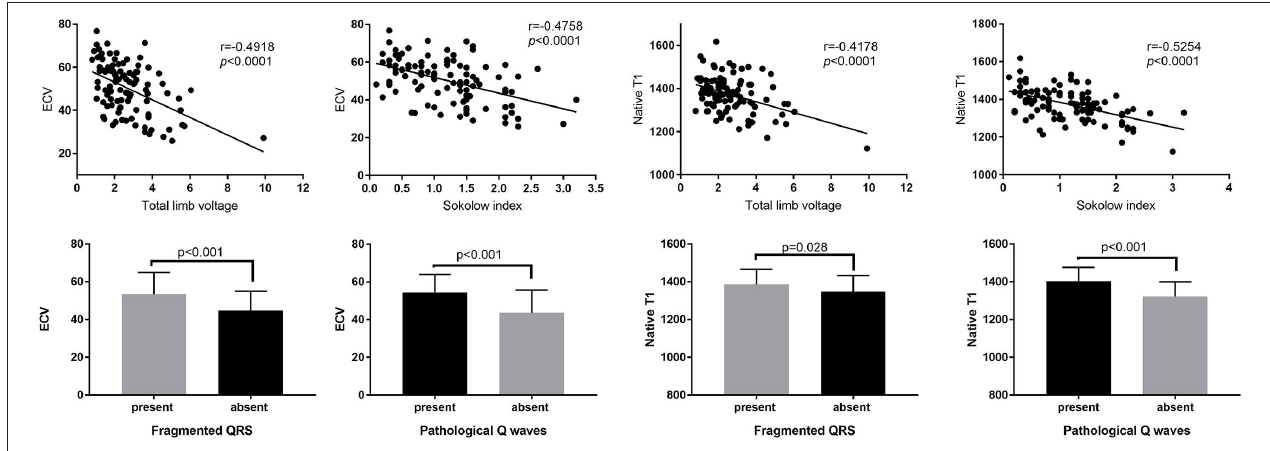
FIGURE 3 | The relationships between ECG parameters and ECV and native T1.